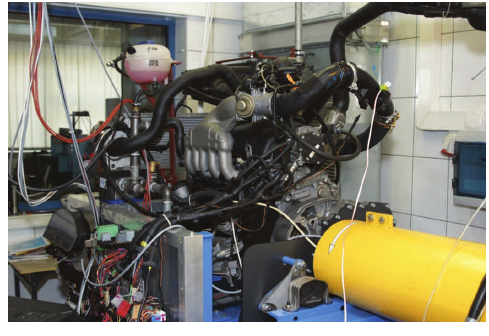
Fig. 8. General view of the test bench